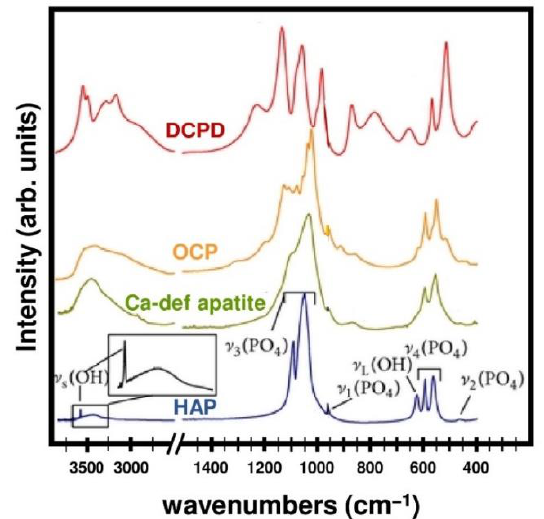
Figure 6. FT-IR spectra of electrodeposited calcium phosphate coatings. Reprinted and adapted with permission from Ref. [112].